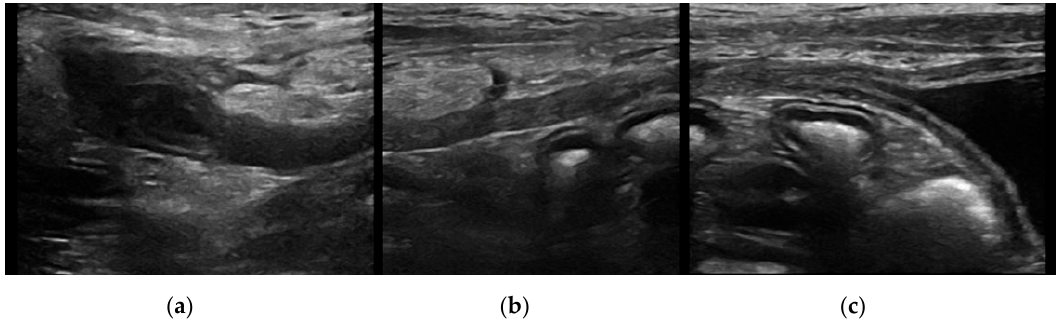
Figure 5. Longitudinal ultrasound images of a patent urachus in a dog. A tubular structure ( ≤ 5 mm diameter) with a small amount of anechoic content extends from the cranio-ventral bladder wall to the umbilical region. Mild reactivity of the peritoneal fat and a small quantity of peritoneal fluid are present in proximity of the urachus. ( a ) Terminal urachus part reaching the umbilical region; ( b ) intermediate urachus part; ( c ) urachus part in continuity with the bladder apex. No urachal sinus was diagnosed during the period of the retrospective study.